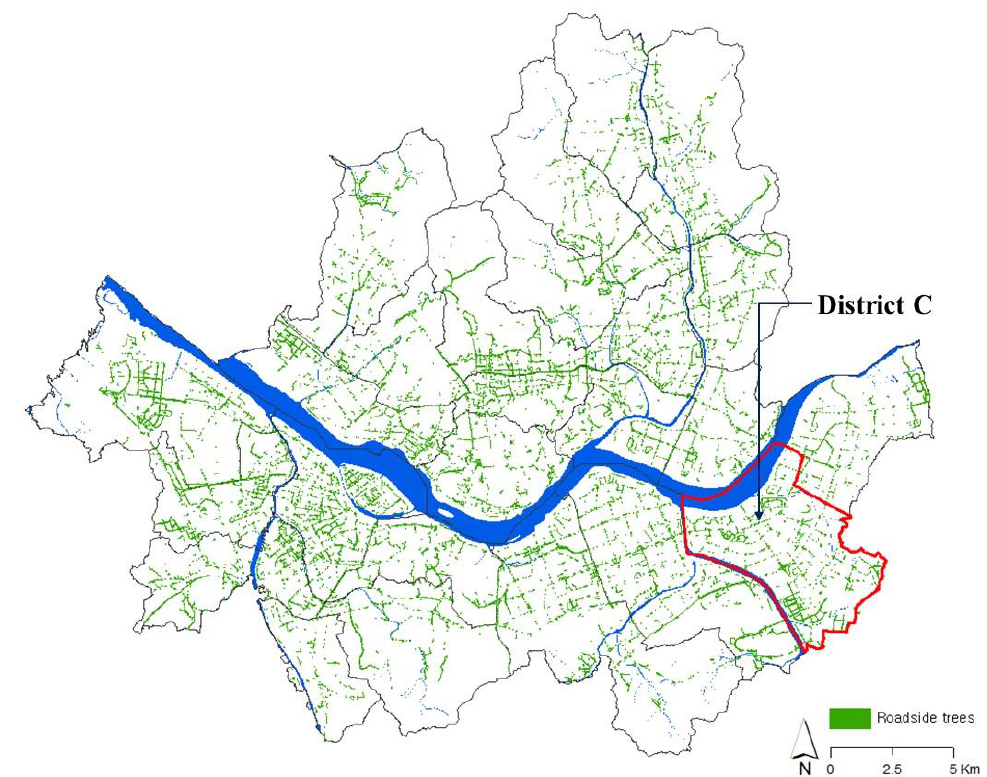
Figure 7. Analysis results of locations suitable for roadside tree planting.